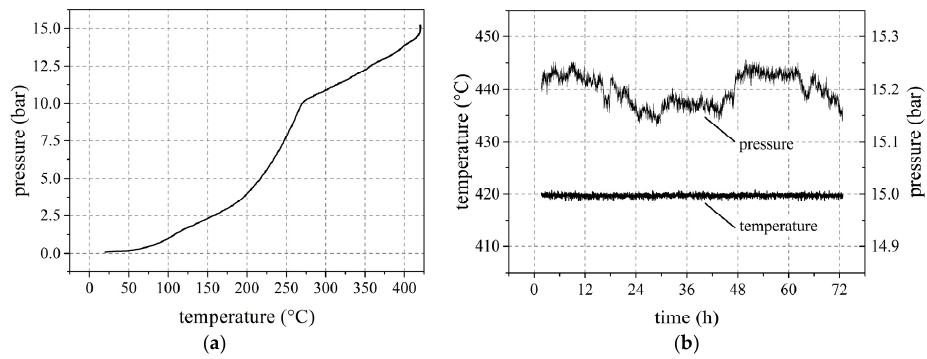
Figure 2. Experiment with a temperature of 420 °C and a duration of 72 h: ( a ) pressure depending on temperature during heating period; and ( b ) temperature and pressure depending on time.